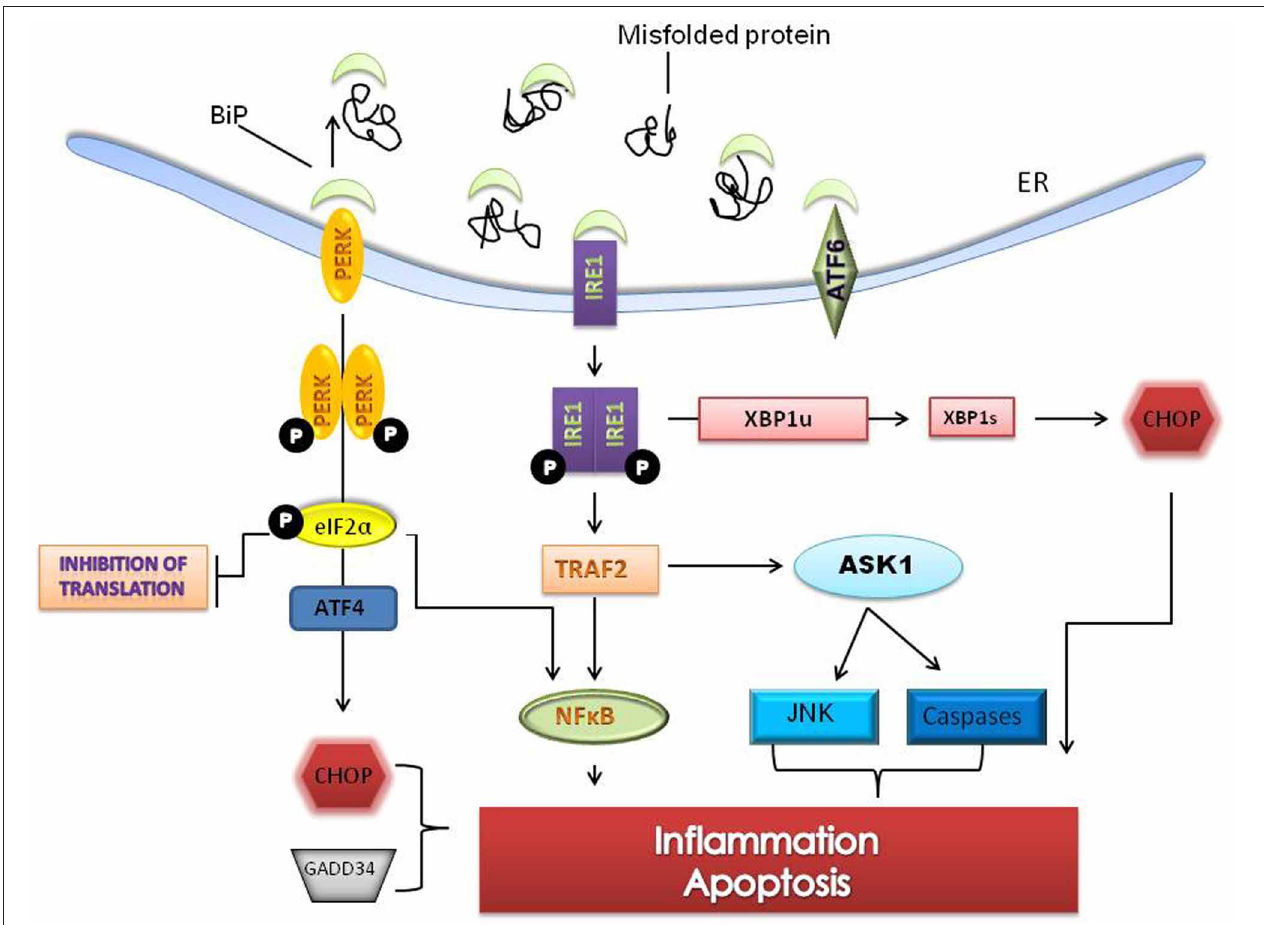
FIGURE 2 | Sustained ER stress leads to pro-apoptotic signaling and cell death. Unresolved ER stress leads to inflammation and cell death pathways involving the PERK and IRE1 branches of the UPR. The IRE1-TRAF2- apoptosis signaling kinase 1 (ASK1) complex upregulates c-jun NH2 terminal kinase (JNK) and caspases and through splicing of XBP1 can activate C/EBP homologous protein (CHOP), a pro-apoptotic transcription